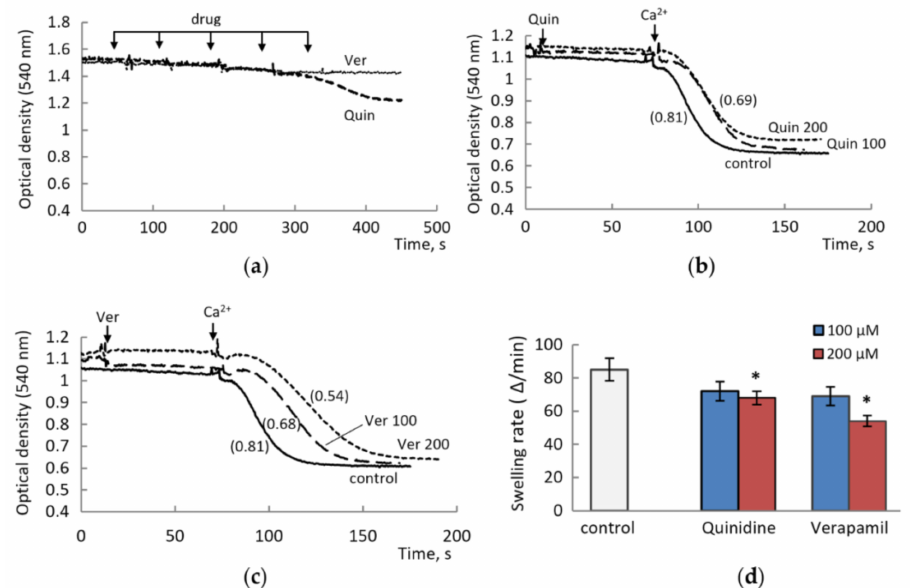
Figure 2. Influence of quinidine and verapamil on the mitochondrial swelling. The influence of quinidine (Quin) and verapamil (Ver) on the mitochondrial swelling in the course of successive additions of 50 µ M drugs ( a ); changes in the rate of Ca 2+ -induced (25 µ M CaCl 2 ) swelling in the presence quinidine ( b ) and verapamil ( c , d ). The swelling rate ( ∆ /min) is indicated in parentheses. Asterisk (*) indicates values that differ significantly from the control values ( p <